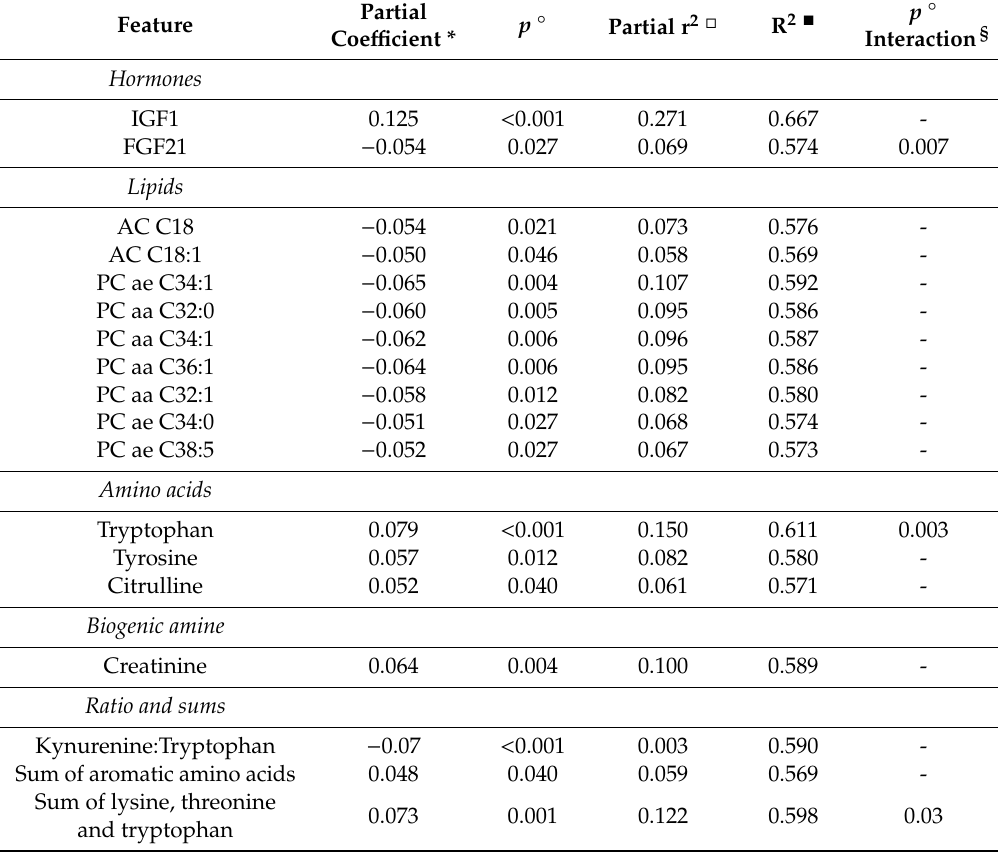
Table 2. Metabolites and hormones significantly associated with lean mass